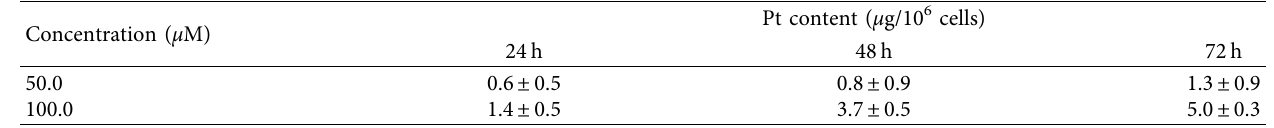
Figure 2: UV-Vis spectra of DBPP in phosphate buffer and 1-octanol at different concentrations: (a) before shaking and (b) after shaking. Insets show the maximum absorbance at 267nm of DBPP. Table 3: Cellular uptake of DBPP in U2OS after 24, 48, and 72h of incubation a .